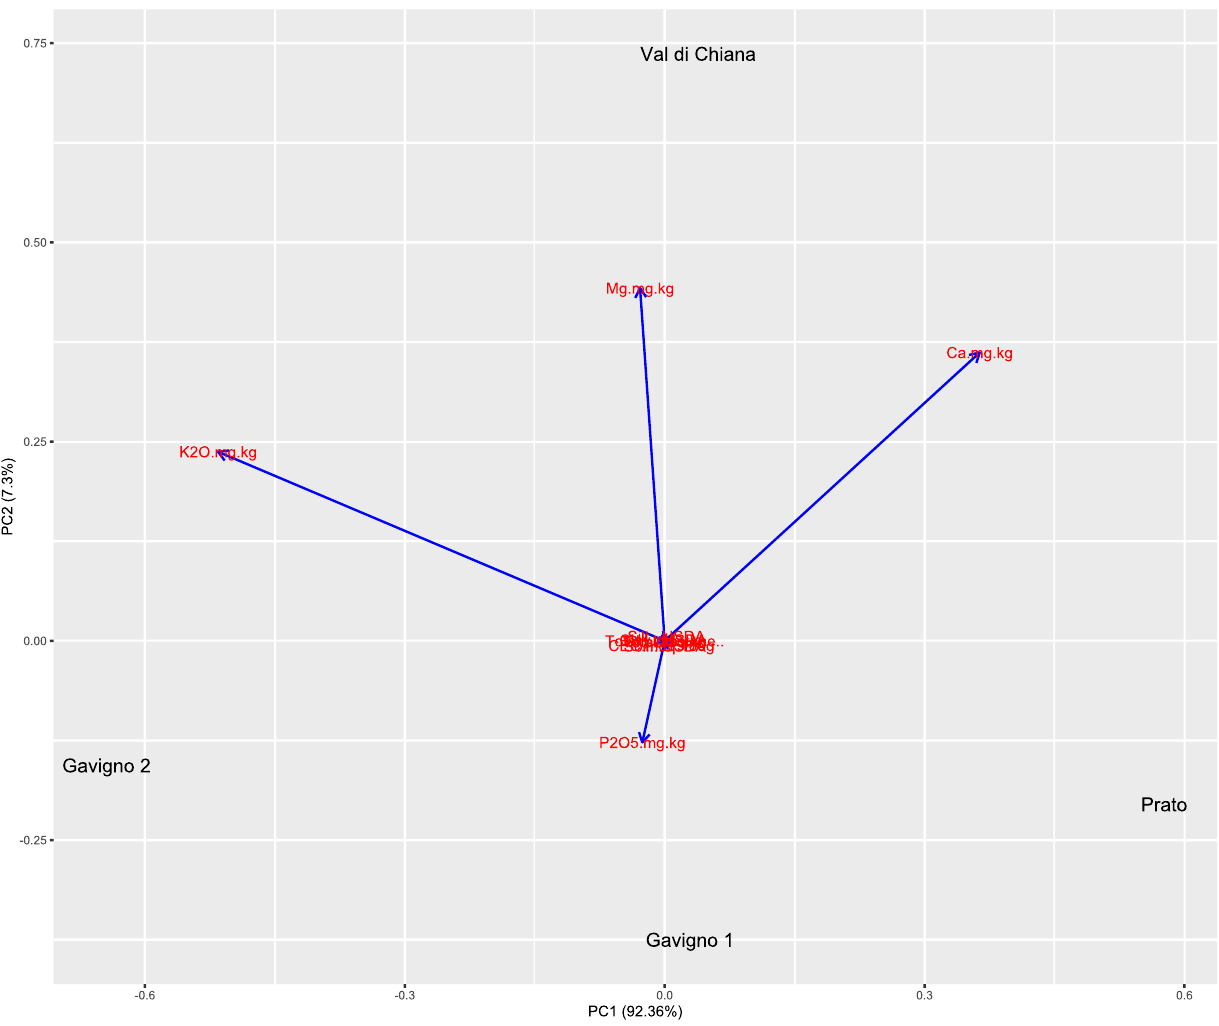
Figure 1. Influence of the physicochemical composition of sampled localities. A principal component analysis, with a biplot, is shown. The percentage of the variance of the first two components is reported. Overlapped labels on the biplot indicate that they do not contribute to the differences among localities.